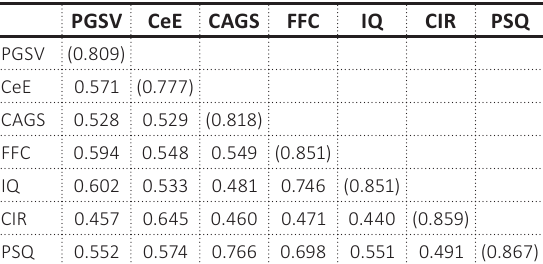
Table 3. Discriminant validity